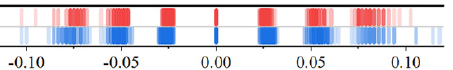
Table 2. Performance of the TDAA [11] and the STAA under different ω